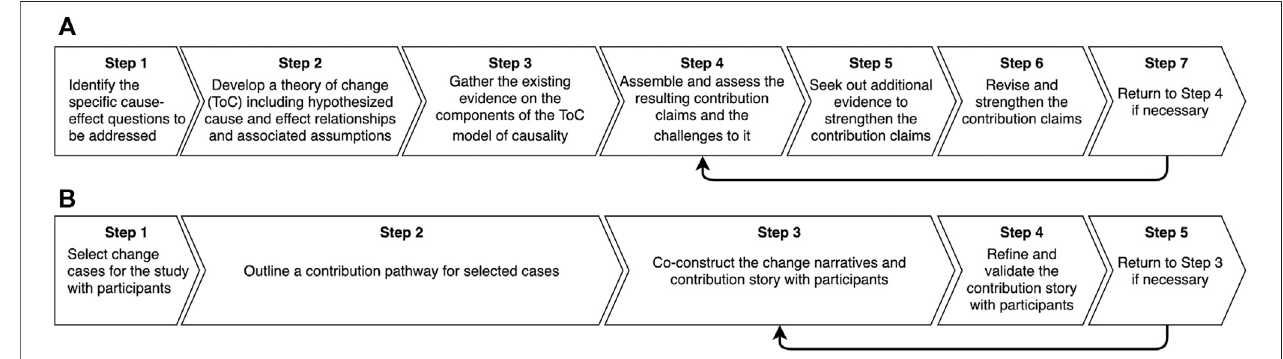
FIGURE1| StepsofMayne ’ s(2011) contribution analysisandthemodi fi edprocedureusedinthisstudy. Figure1 comparesMayne ’ s(2011) contribution analysis to the steps that were used to assess the contribution of social learning to programs ’ outcomes and impacts in this study.